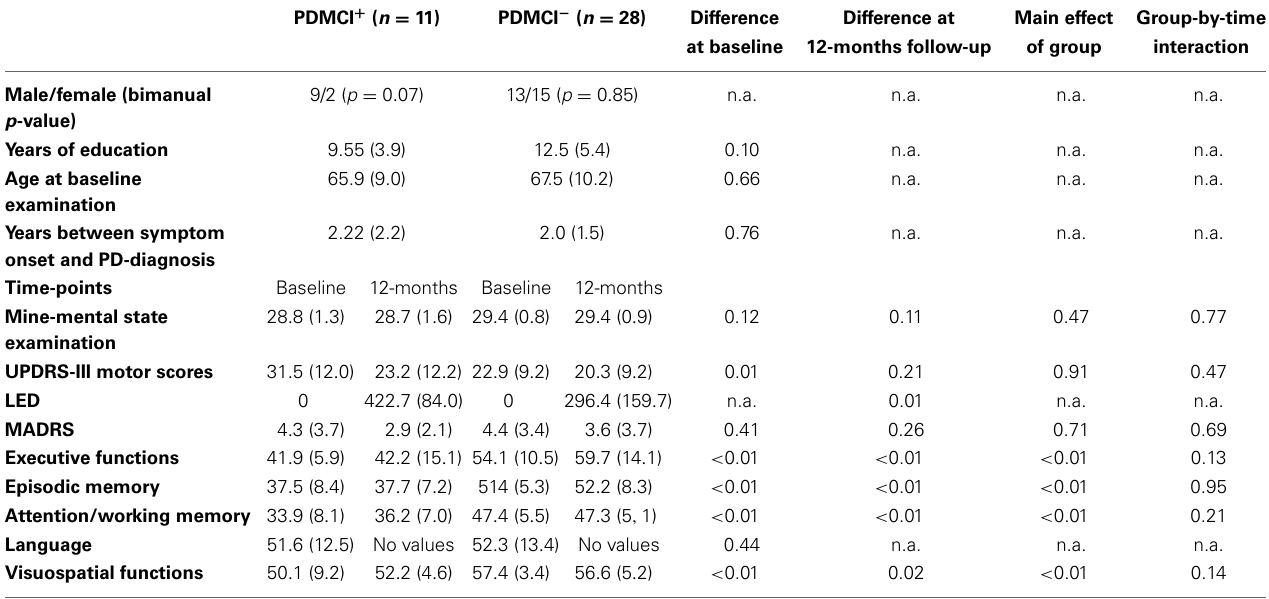
Table 1 | Demographics and clinical